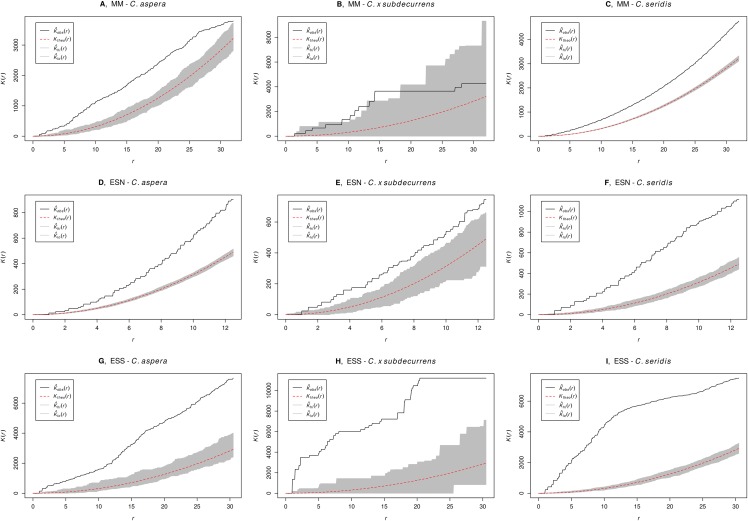
Ripley’s K observed and expected with random distribution for the combined data of all plots, with confidence intervals calculated using Monte Carlo simulations for a Poisson distribution.Ripley’s K observed: black, Ripley’s K expected with random distribution: red, confidence intervals: grey. Values larger than the upper confidence limit indicate significant intracytotype aggregation at the particular distance of r. (A–C) Marjal dels Moros (MM), (D–F) El Saler North (ESN), and (G–I) El Saler South (ESS). (A, D, G) C. aspera, (B, E, H) C. x subdecurrens, and (C, F, I) C. seridis.